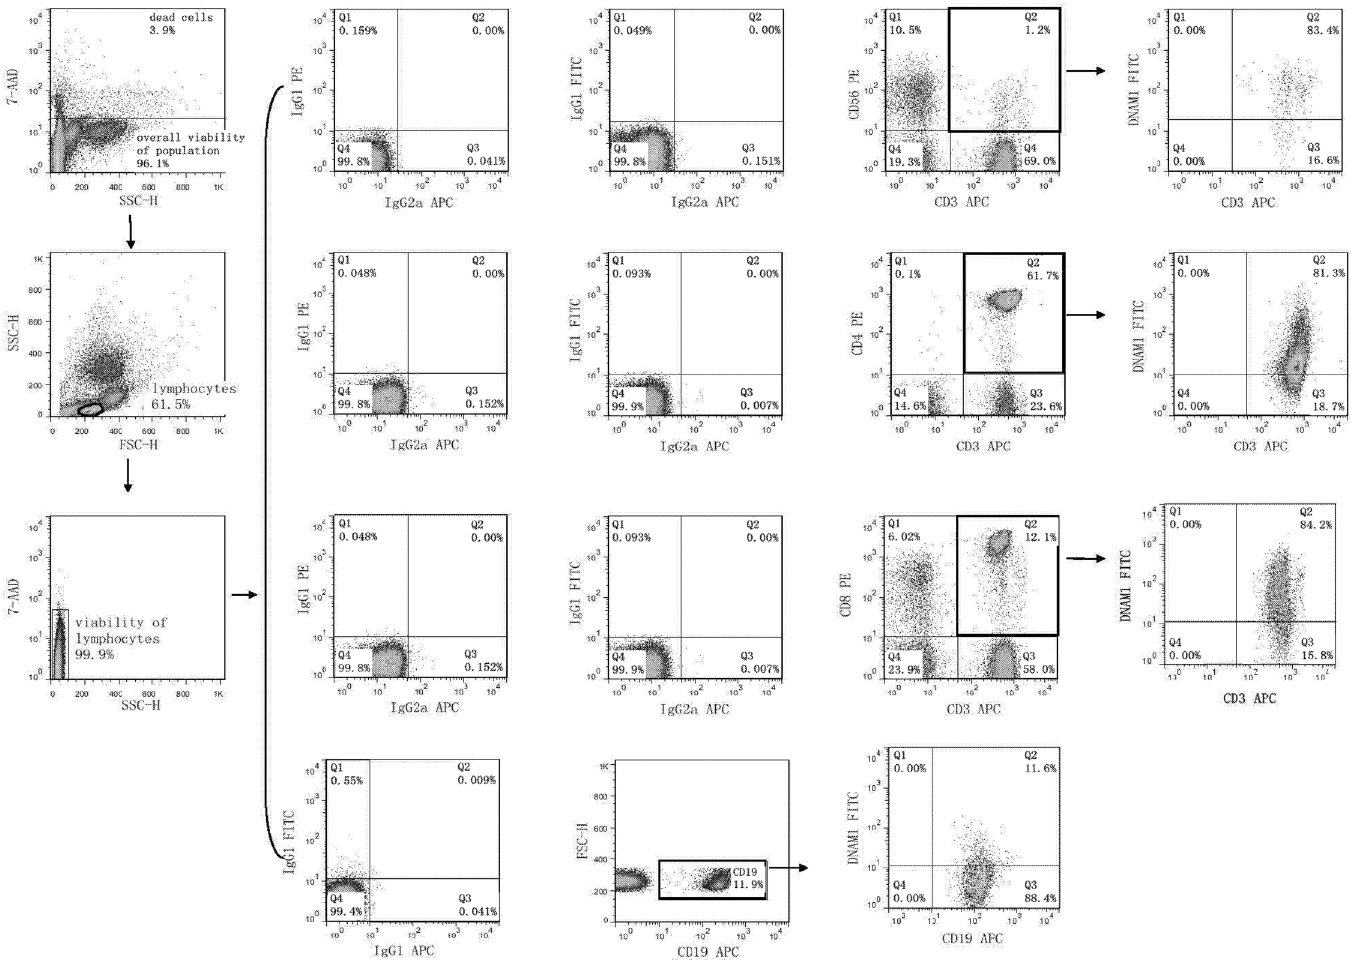
Fig 1. The expression of DNAM-1/CD226 on CD3 + CD56 + NKT cells, CD4 + T cells, CD8 + T cells and CD19 + B cells present within the fraction of unstimulated mononuclear cells immediately after the isolation from peripheral blood of healthy